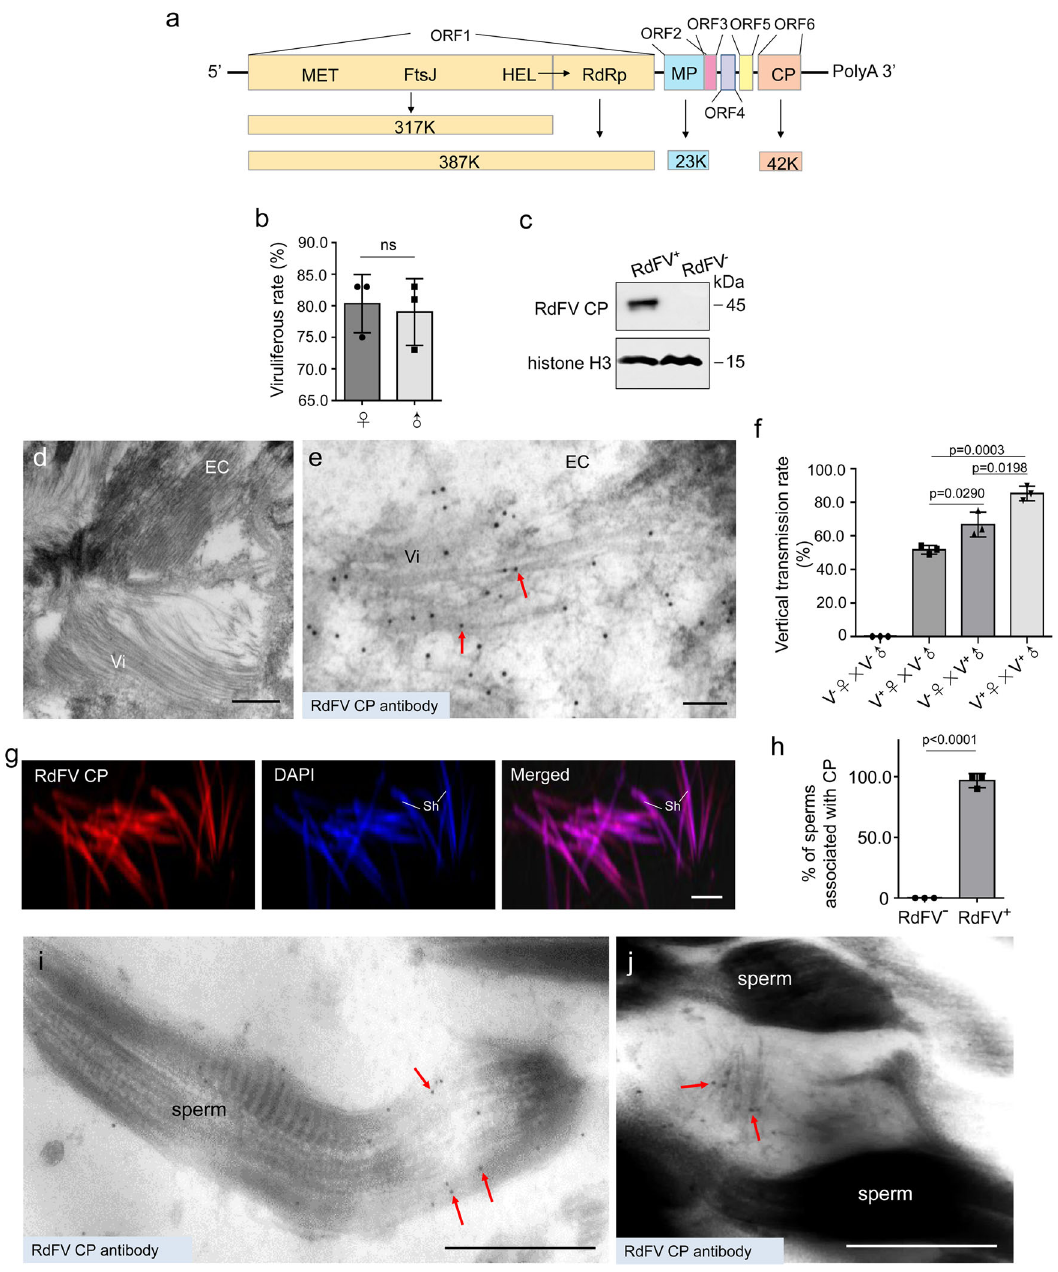
Fig. 1 | Sperm-mediated paternal transmission of RdFV by male R. dorsalis . a Diagram of the genome organization of RdFV. Solid lines represent RNA; boxes indicatepredictedORFs.MET,methyltransferase;FtsJ,ftsJ-likemethylthransferase; HEL, superfamily 1 helicase; RdRp, RNA-dependent RNA polymerase; MP, move- ment protein; CP, capsid protein. b Viruliferous rates in 100 male or female adults by RT-PCR assays for testing the transcript of RdFV CP . Means (± SD) represent three biological replicates (two-tailedt-test).Ns, not signi fi cant. c Accumulation of RdFV CP in 30 RdFV-positive or free leafhoppers, as determined by western blot assays by using HongrES1 or histone H3 antibody. Data represent three biological replicates. d Electron micrographs showing fi lamentous viral particles within the midgut epithelium of RdFV-positive leafhoppers. Bar, 500nm. e Immunoelectron micrographs showing the localization of RdFV CP on fi lamentous viral particles within the midgut epithelium of RdFV-positive leafhoppers. EC, epithelial cell. Vi, virions. Bar, 100nm. f Vertical transmission rates ofRdFV caused by RdFV-positive